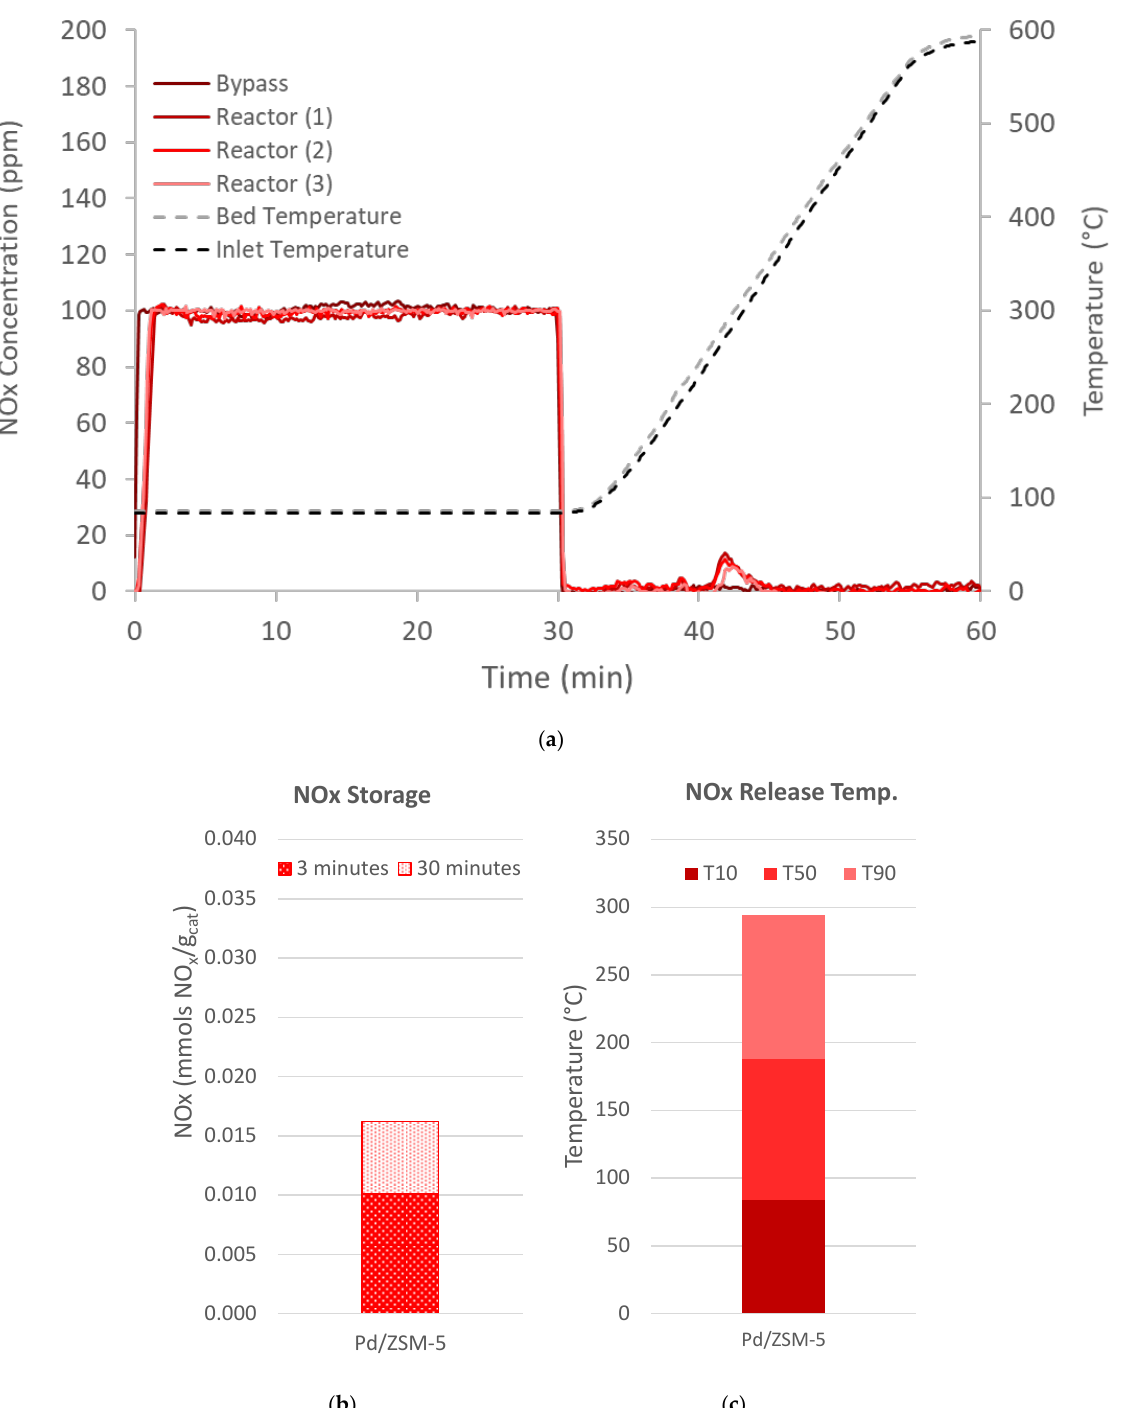
Figure 4. ( a ) NOx concentration for each of the three reactor evaluations throughout the 60 min experiment. ( b ) NOx adsorption after 3 ( ) and 30 ( ) minutes for Pd ZSM-5, and ( c ) the temperature where 10% (T10, ■ ), 50% (T50, ■ ), or 90% (T90, ■ ) of the NOx is released for PD/ZSM-5.